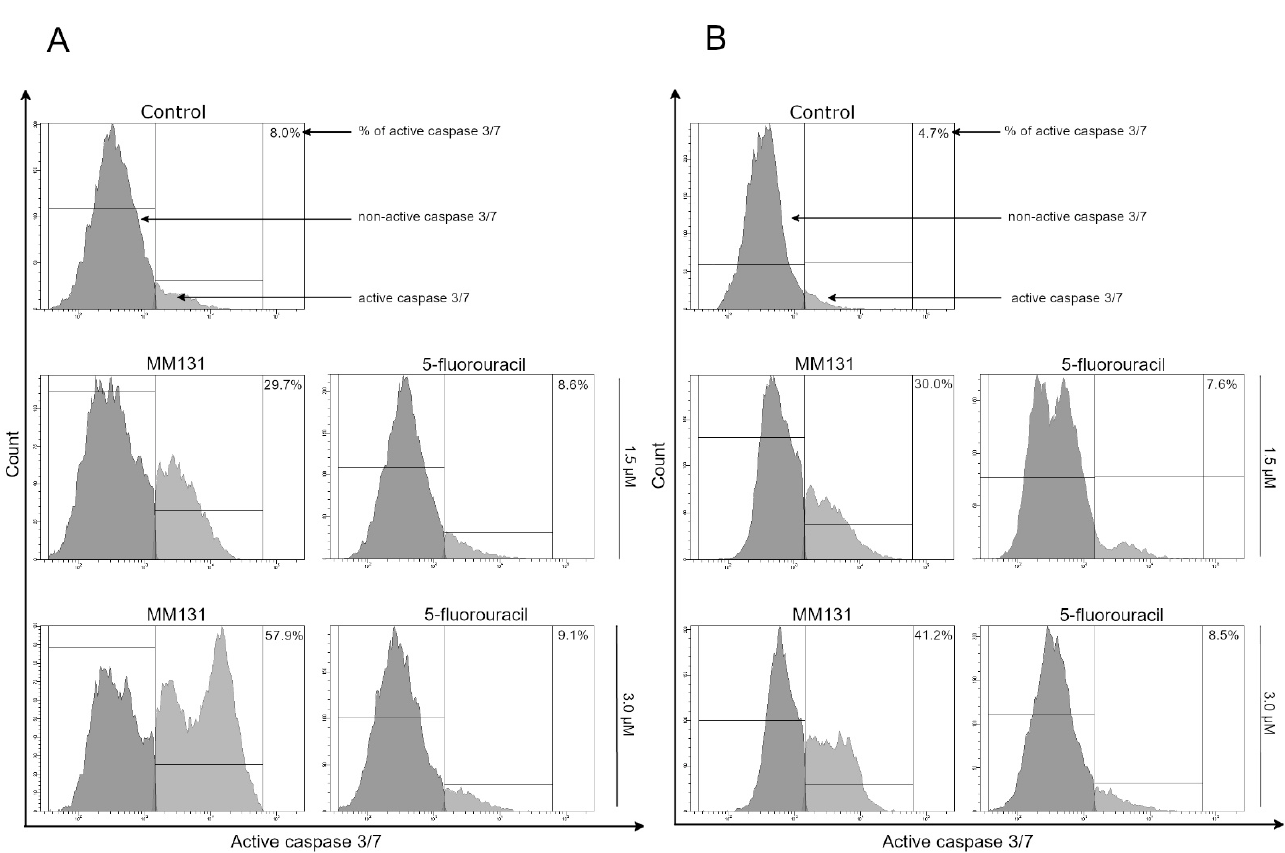
Figure 7. Caspase-3/7 activity utilizing flow cytometry analysis following 24 h of incubation with MM131 and 5-fluorouracil in DLD-1 ( A ) and HT-29 ( B ) colorectal cancer cells. The total number of cells with active caspase-3/7 is demonstrated as a mean of three separate experiments.